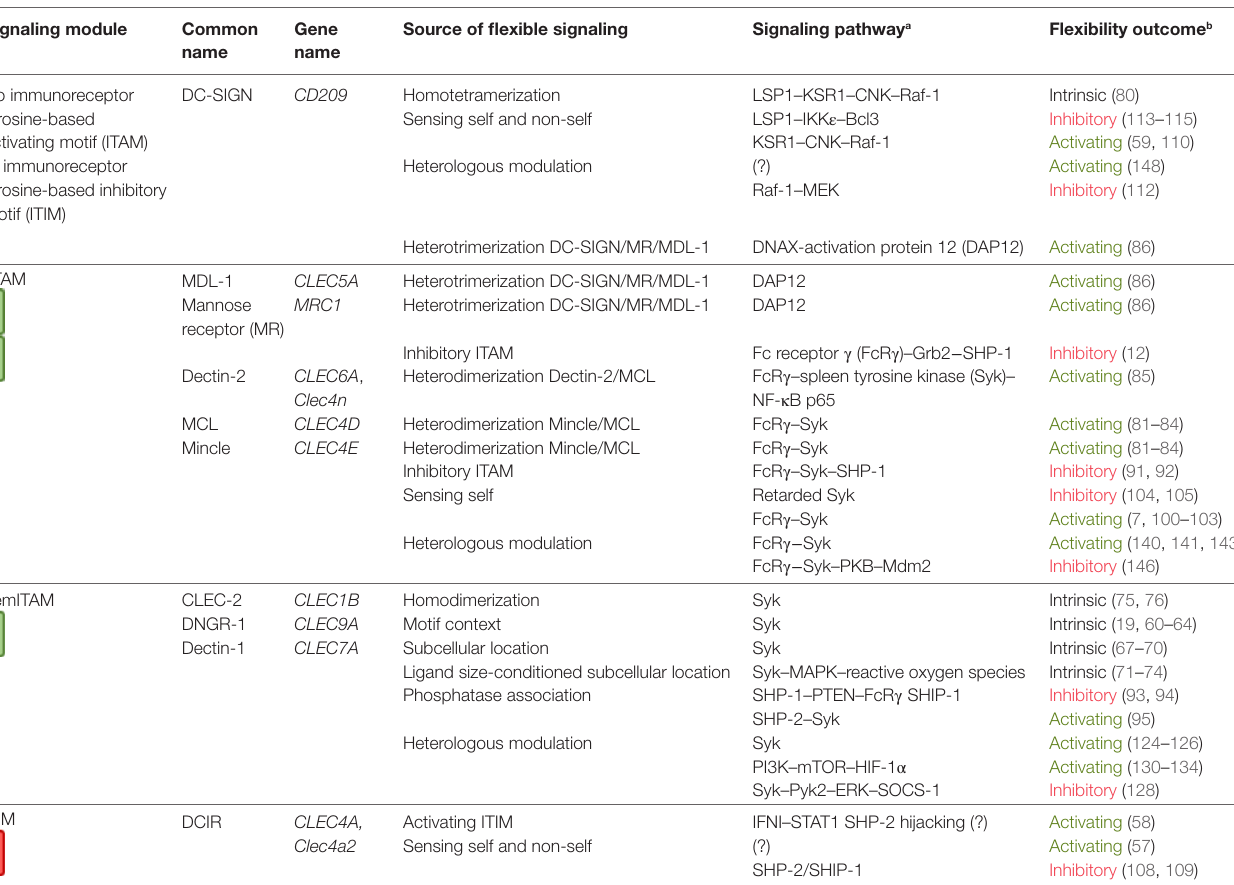
TAbLe 1 | Myeloid C-type lectin receptors (CLRs) surveyed in this